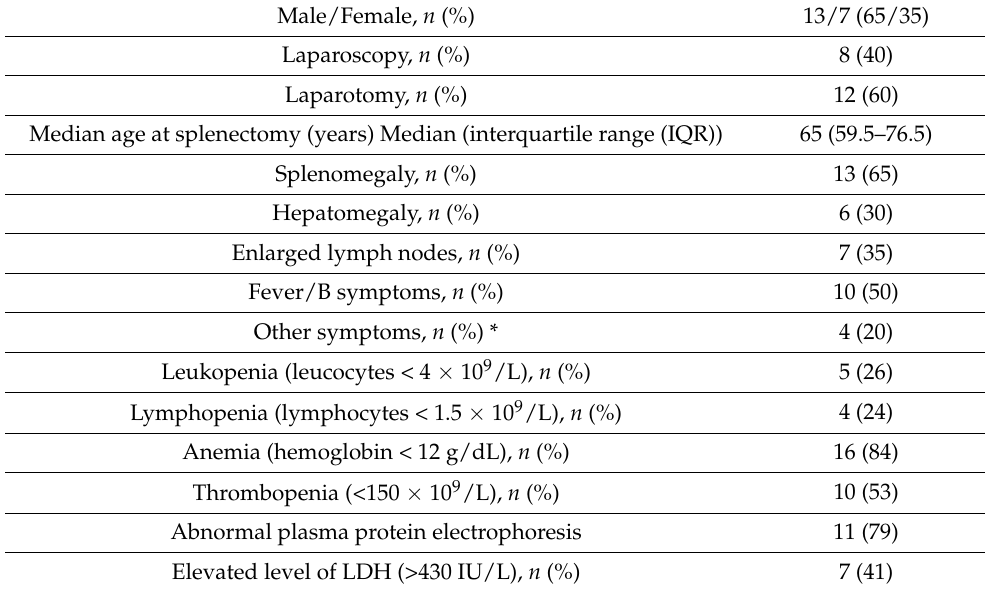
Table 1. Patient demographic, clinical, and biological